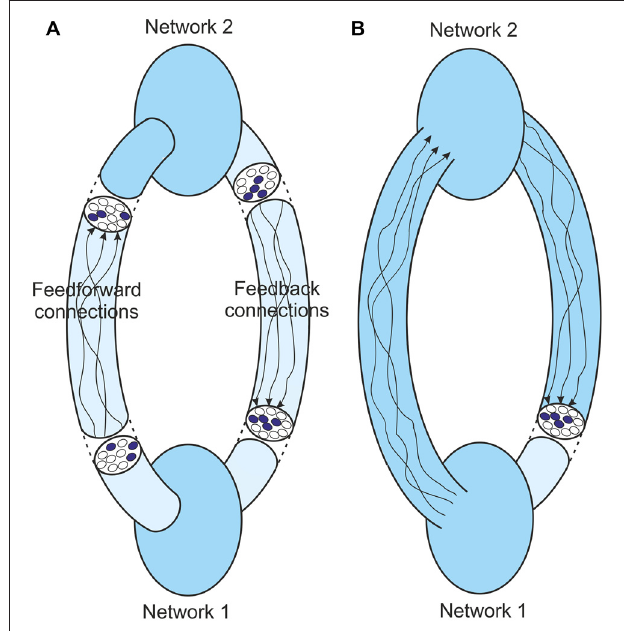
FIGURE 6 | (A) Feedback in a two-network loop at resonance. The structures at different points in the system settle to a constant pattern, but the feedforward and feedback paths are convoluted and lead to quite different stable structures at different points. (B) The same system with the boundary of Network 1 extended to just before its input. At resonance the input to this network is the same as its output. Importantly the output is still a representation of the last message obtained by Network